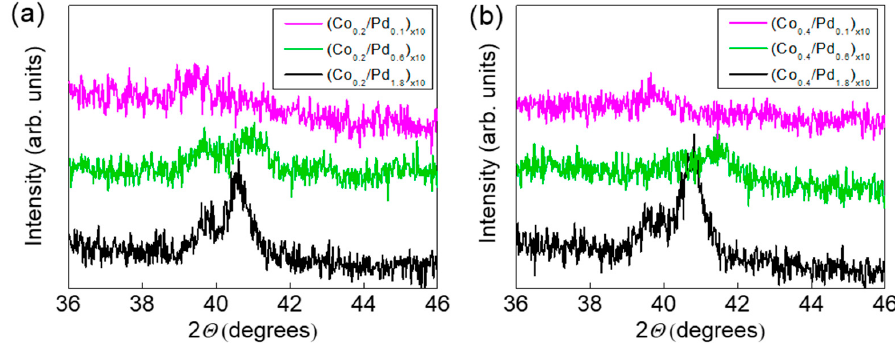
Figure 5. XRD ( θ -2 θ ) patterns corresponding to samples of ( a ) series 3 and ( b ) series 4. A small peak at ~39.5° corresponds to the substrate.